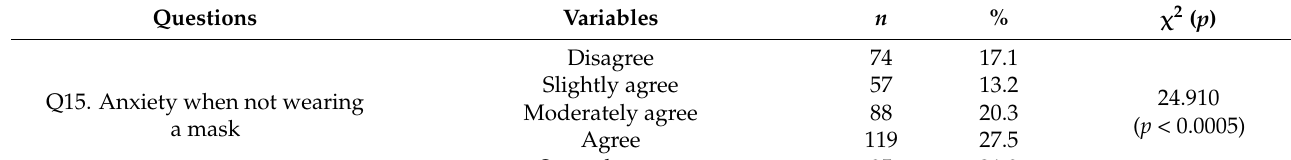
Table 4. Survey results: anxiety due to not wearing a mask and plan to wear a